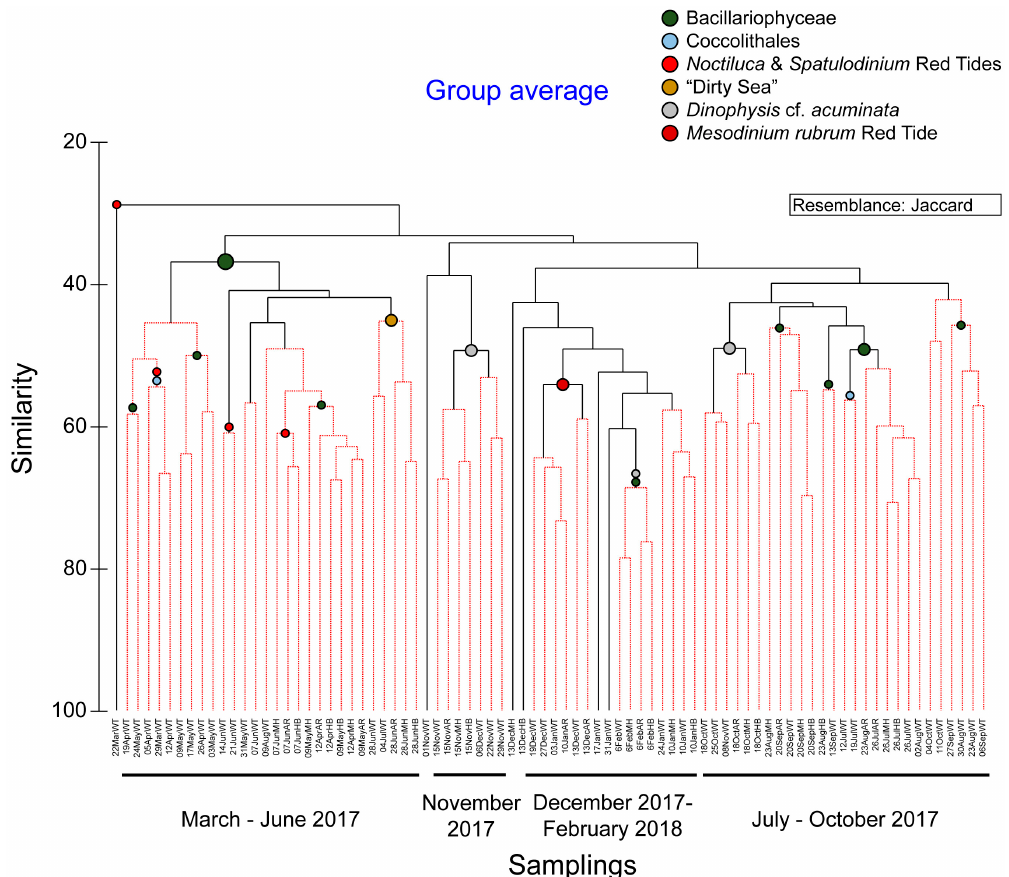
Figure 3. Cluster diagram according to Jaccard resemblance, calculated based on the non-transformed abundance (cells mL − 1 ) of taxa during the study. Red clades in the dendrogram indicate sections of the plot where the observed profile corresponds to similarities that are larger than those expected under null conditions ( > 99% of the confidence envelope), suggesting the presence of true structure within the data. The nodes represent the dominant taxa blooming during the period covered by the corresponding clades.